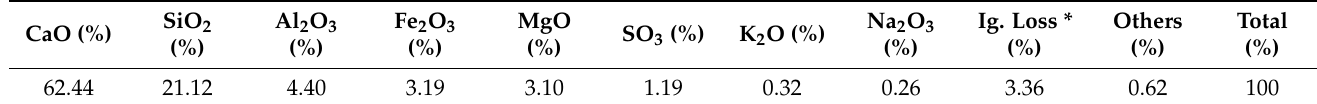
Table 4. Chemical composition of the cement.